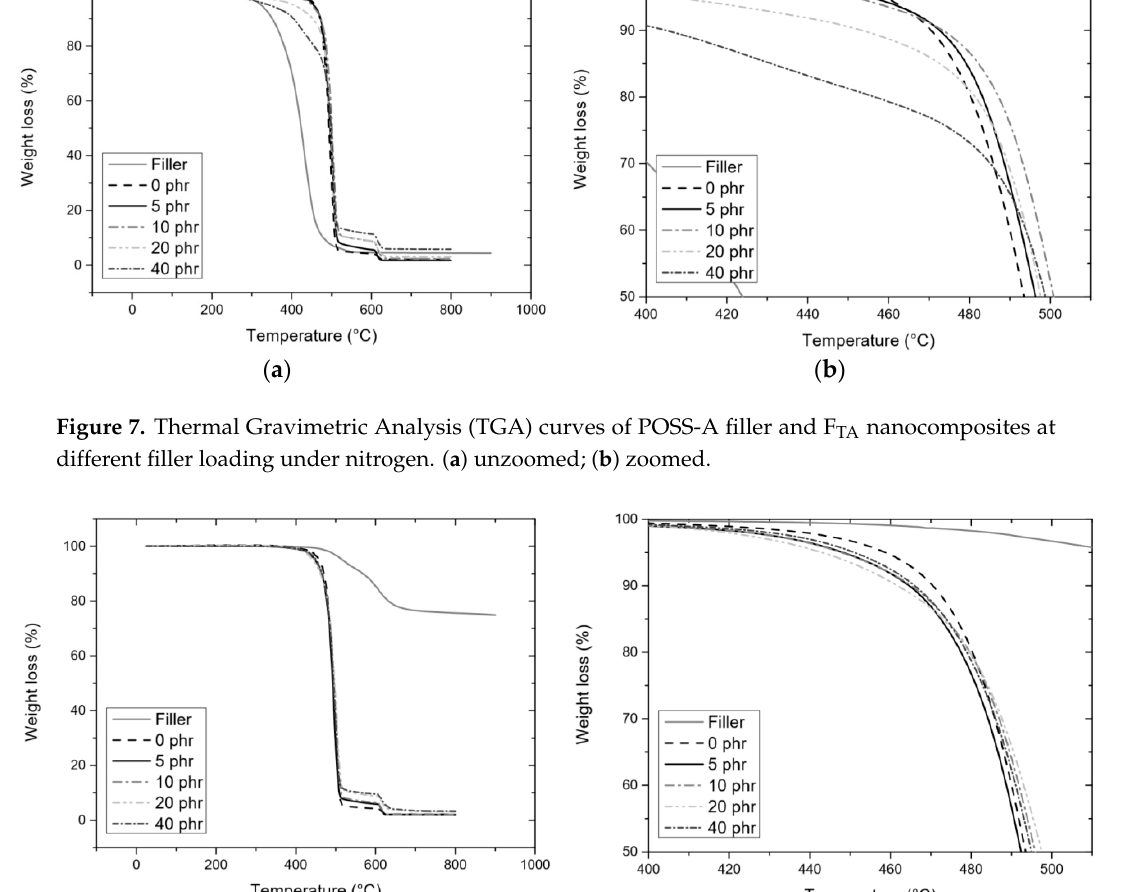
( b ) Figure 9. Thermal Gravimetric Analysis (TGA) curves of POSS ‐ F filler and F TF nanocomposites at different filler loading under nitrogen. ( a ) unzoomed; ( b ) zoomed. 3.4. Mechanical Characterization 3.4.1. Tensile Tests Given appropriate film forming properties and promising thermal behavior, POSS ‐ A and POSS ‐ P composites were selected for further investigations of their mechanical properties. Measurements were realized without the elimination of Mullins effect [37]. The tensile properties of the compounds were